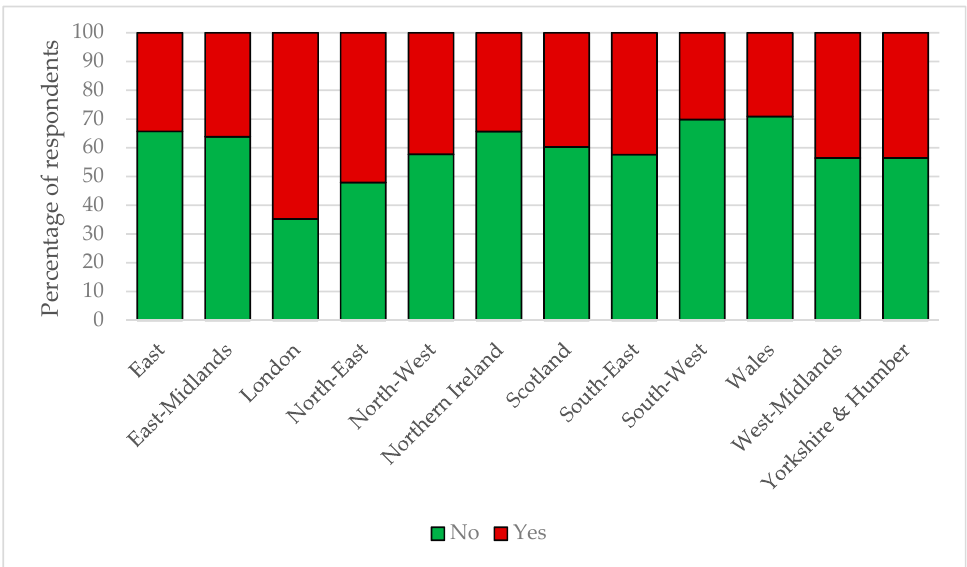
Figure 7. Percentages of horse owners experiencing a reduced frequency of visits to their horses due to COVID-19 restrictions across UK regions. Horse owners stated if they had or had not been required to visit their horse / s less since COVID-19 restrictions were implemented. The data are reported by United Kingdom geographical